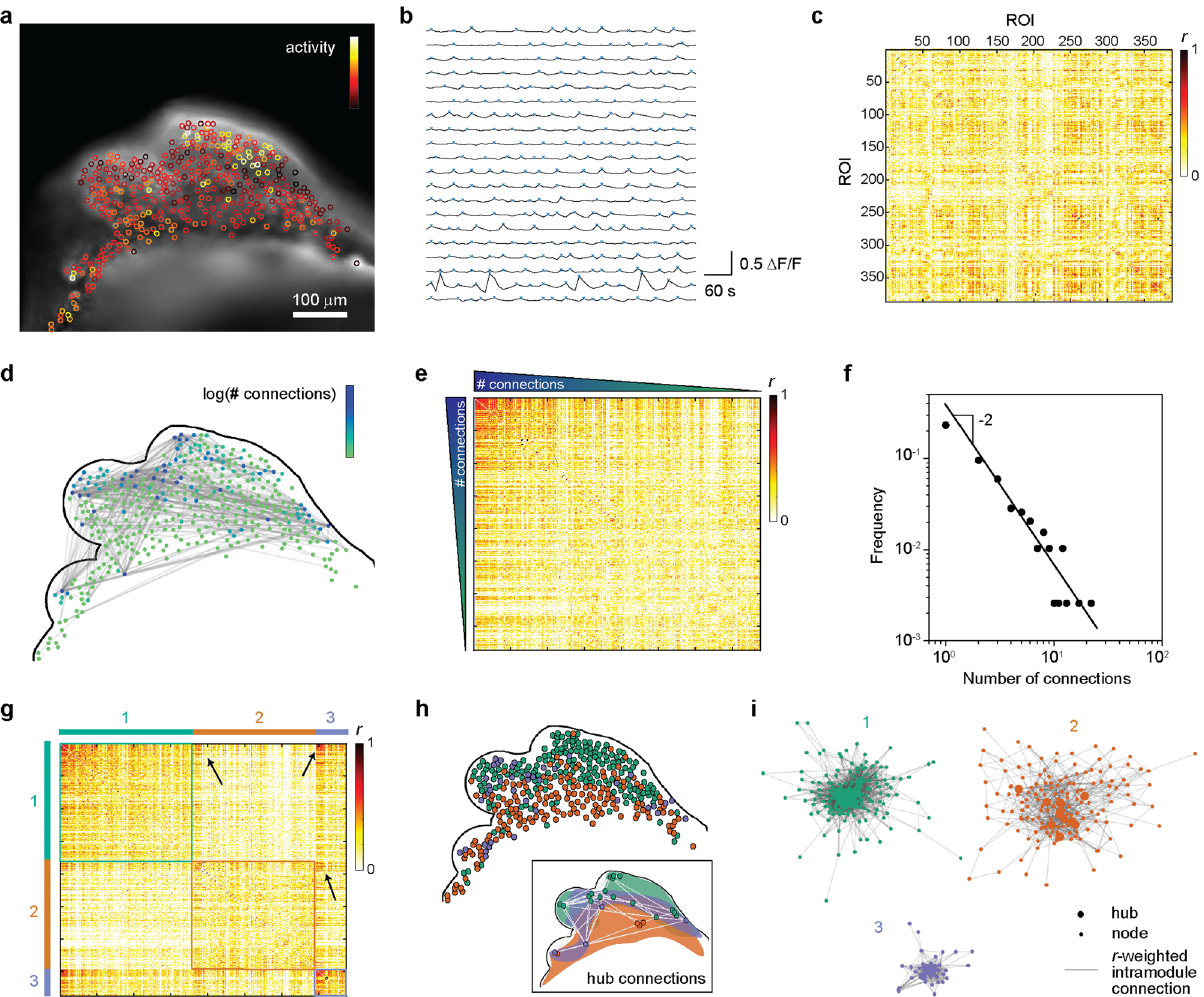
Fig. 2 Functional network interconnectivity in intact MARC-produced cerebral tissues. a Neuronal activity in a cerebral tissue at week 4 of MARC culture. A snapshot of live fl uorescence calcium imaging on the intact cerebral tissue is overlaid with regions-of-interest (ROIs) color-coded based on the frequency of detected calcium surges ( “ activity ” ) in each ROI. See Supplementary Movie 1 for the corresponding time-lapse imaging data. Scale bar: 100 µ m. b Representative time traces of normalized intensity ( Δ F/F) from 20 ROIs. Blue crosses indicate detected transient spikes. Time traces from 387 ROIs in the image are used to compute the correlation coef fi cient r ij between ROI pairs i and j (see Methods for details of calculation). c Correlation matrix between any pair of the 387 ROIs, showing the r -value for each pair. d Depiction of functional connectivity network in the cerebral tissue. The contour of the cerebral tissue, corresponding to a , is shown. Two ROIs are de fi ned to be functionally connected when r > 0.6 and shown as gray lines in the connectivity map. Further, each ROI in the connectivity map is color-coded based on the number of functional connections it has. e The same correlation matrix as in c , but with the ROIs sorted based on the number of functional connections they have. The high density of ROI pairs with a high number of connections and high r -value suggests a non-random network topology. f Distribution of the number of functional connections. The distribution follows a power law with a decaying power of − 2, demonstrating a scale-free cerebral tissue functional network. g Clustered correlation matrix. To test whether the network exhibits modular topology, the functional connectivities are analyzed using the Louvain algorithm 33 , which indicates that the network contains three communities/modules. The correlation matrix in d is then reordered so that the nodes in the same module (color-coded with 1, 2, and 3) are positioned together. The high density of cross-module node pairs with high r -values (arrows) suggests the existence of hub connections between modules. h The localization of the nodes in the three modules. The color of the nodes corresponds to the color-coding of the three modules in g . The inset shows the spatial regions that enclose the nodes identi fi ed in the three modules, together with the hub nodes (de fi ned as nodes with a number of intra-module connections larger than the 90th percentile in the module) and the cross-module hub connections (gray lines). i Topological representation of the intra- module functional connectivity networks. To illustrate the topological proximity of highly connected nodes, each module network is shown using the Fruchterman – Reingold algorithm 44 , where the length of the lines connecting nodes is proportional to 1 − r (i.e., short lines indicate a high correlation coef fi cient between the node pairs and the converse). The hubs in each module are also indicated. The central positioning of the hub nodes, as well as the close topological proximity between the hub nodes, highlight their status as intramodular connector nodes in the cerebral tissue functional